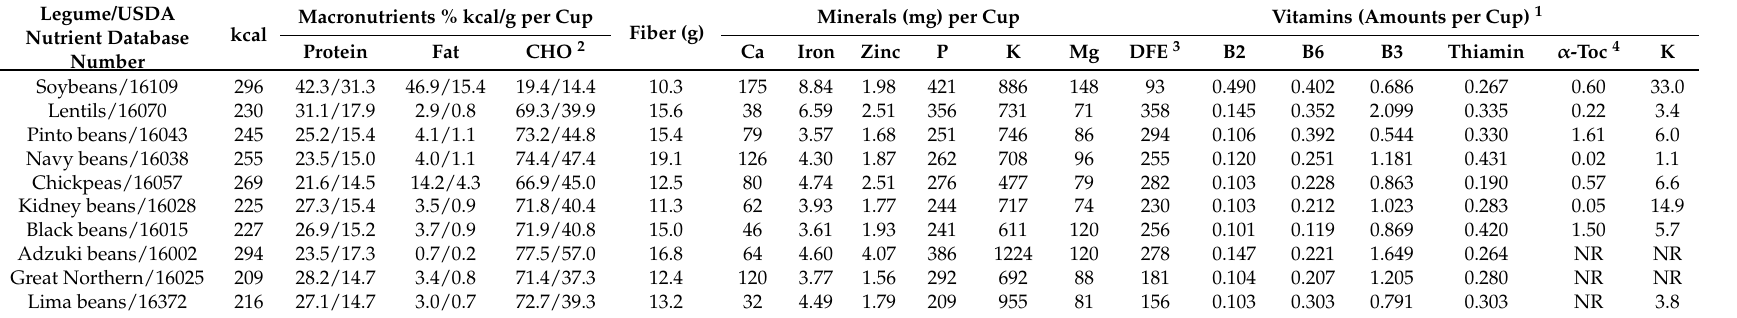
Table 1. Nutrient composition of boiled soybeans and selected legumes per cup (source, reference